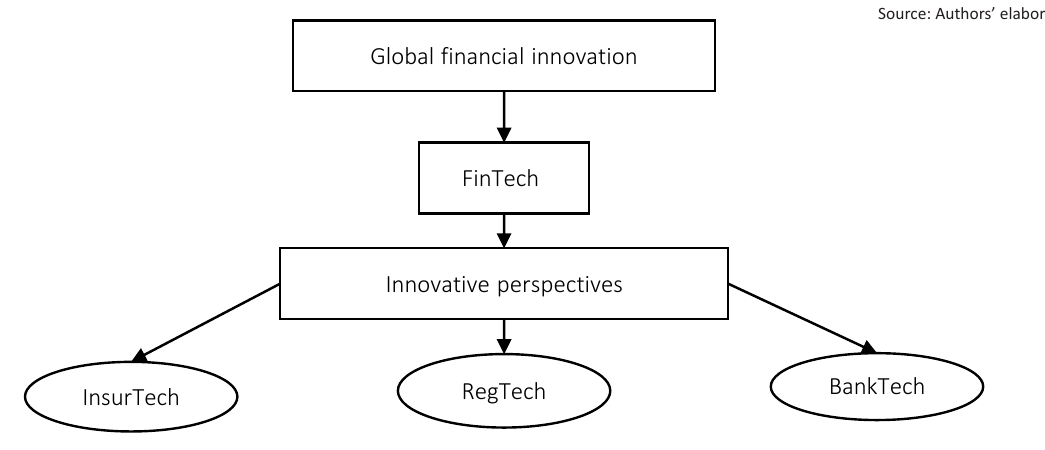
Figure 1. Innovative prospects for global financial